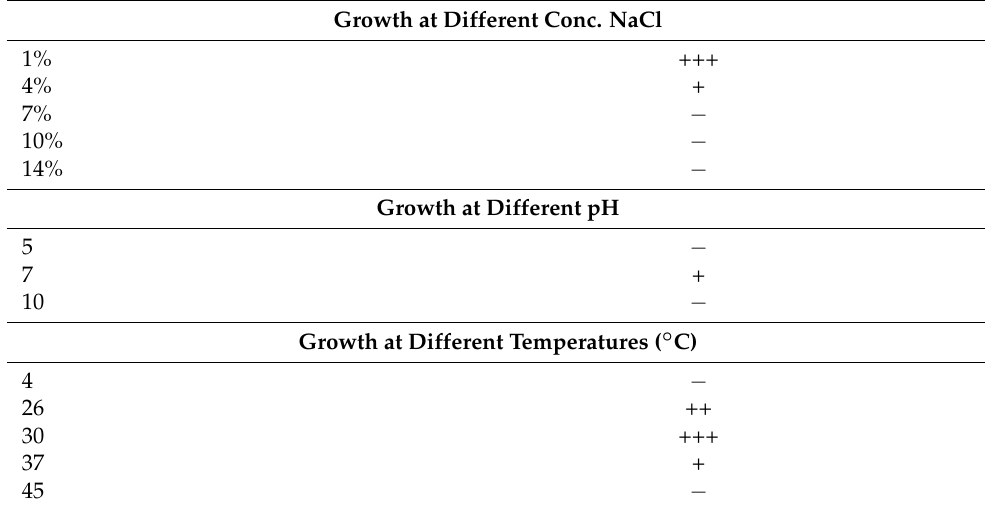
Table 2. Physicochemical properties of Streptomyces sp. strain ess_amH1. Growth at Different Conc.